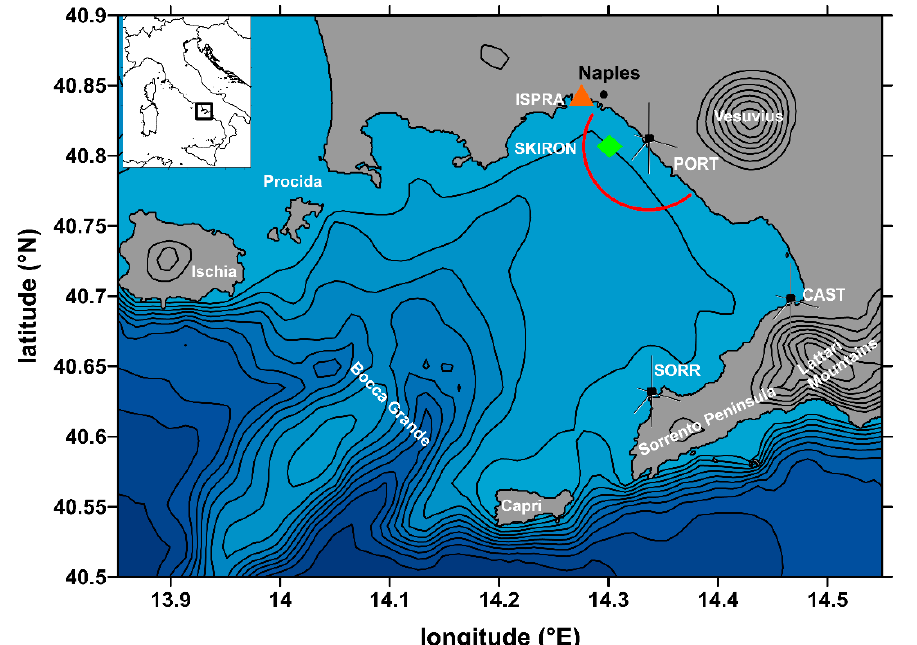
Figure 1. Map of the Gulf of Naples (GoN) (Tyrrhenian Sea, see inset) with the locations of the three High Frequency radar (HFr) sites Portici (PORT), Castellammare di Stabia (CAST) and Massa Lubrense (SORR) (black antenna symbols), of the Istituto Superiore per la Protezione e la Ricerca Ambientale (ISPRA) weather station (orange triangle) and of the SKIRON/Eta model output point (green diamond). The red semi-circle represents the Range Cell 5 (RC5) used to retrieve the wind direction from the HFr data (see text). Toponyms of the main geographic sites are indicated. The bathymetric and orographic contours are spaced every 100 m; elevation iso-lines are plotted starting from 300 m for graphical reasons. Coastline data: NOAA National Geophysical Data Center, Coastline extract-ed: WLC (World Coast Line), Date Retrieved: 1 April 2015, http://www.ngdc.noaa.gov/mgg/shorelines/shorelines.html; bathymetric and elevation data from [40] (Access date: 8 September 2011).